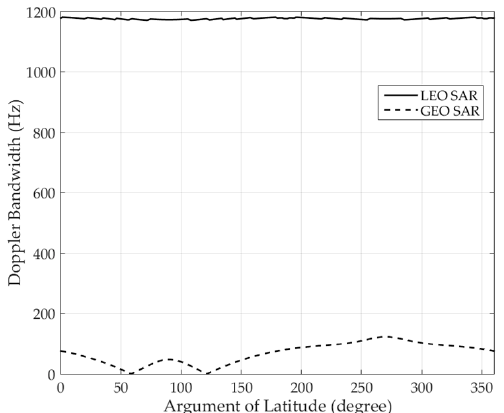
Figure 6. Doppler bandwidths of GEO SAR and low earth orbit (LEO) SAR with an azimuth resolution of 5 m based on Equations (7) and (10). We consider L-band GEO SAR in orbit with an inclination angle of 60°. The parameters employed for LEO SAR are the same as those of L-band ALOS-2 [19]. In this case, the Doppler bandwidth of GEO SAR is nearly 1/10 that of LEO SAR.